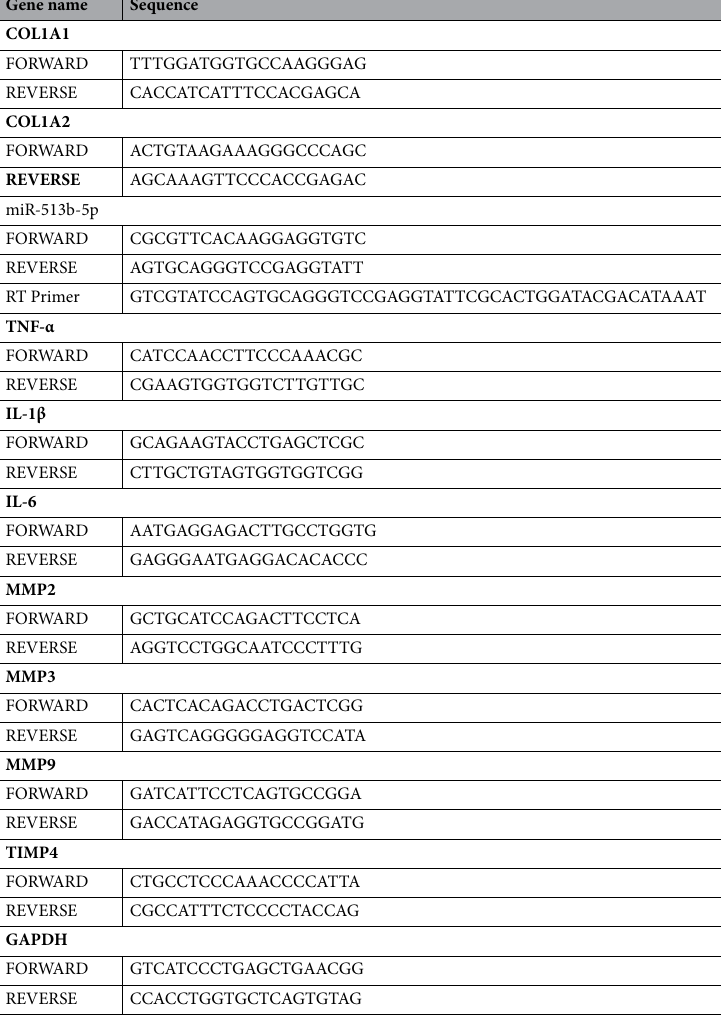
Table 1. Primers information. COL1A1, Collagen type I alpha 1 chain; TNF-α, Tumor necrosis factor alpha; IL-1β, Interleukin (IL) 1 beta; MMP2, Matrix metalloproteinases (MMP) 2; TIMP4, Tissue inhibitor of metallopeptidase